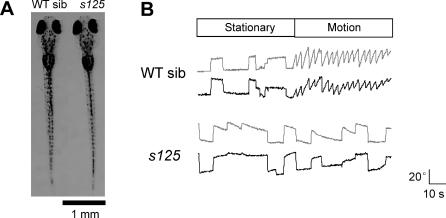
Example of an OKR Mutant with Normal Morphology(A) WT sibling and zats125 mutants are indistinguishable in their appearance (shown here at 6 dpf).(B) The mutant showed no OKR, but saccadic eye movements, which were not correlated to the motion stimulus. The zat gene encodes cone-specific Gc3.